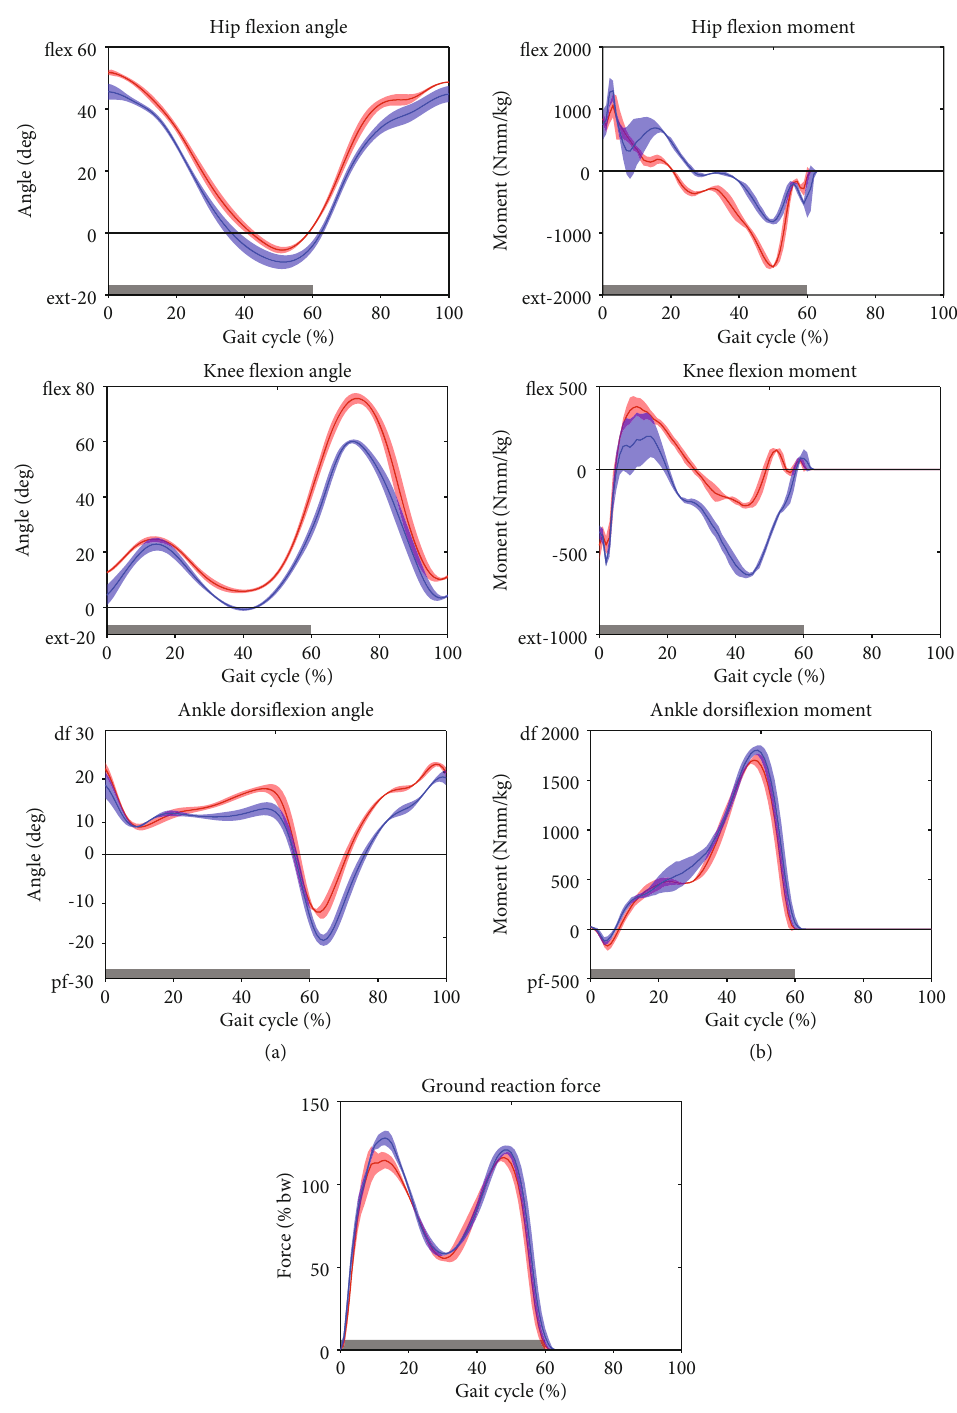
Figure 5: Joint angles (a) and resultant external joint moments (b) in the sagittal plane and vertical ground reaction force (c) during walking. Gait data was normalized to one gait